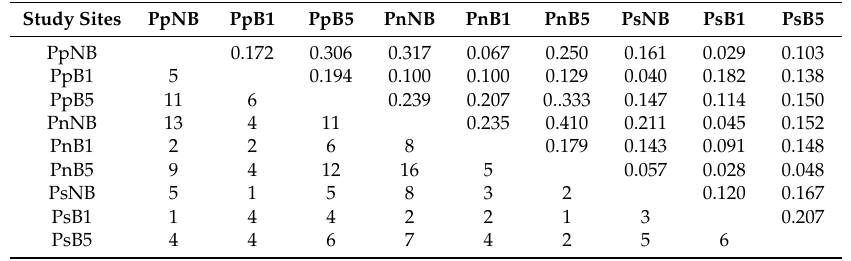
Table 3. Jaccard similarity coefficients (lightface) and the number of genera in common (boldface) among the three different study sites at different periods after fire.